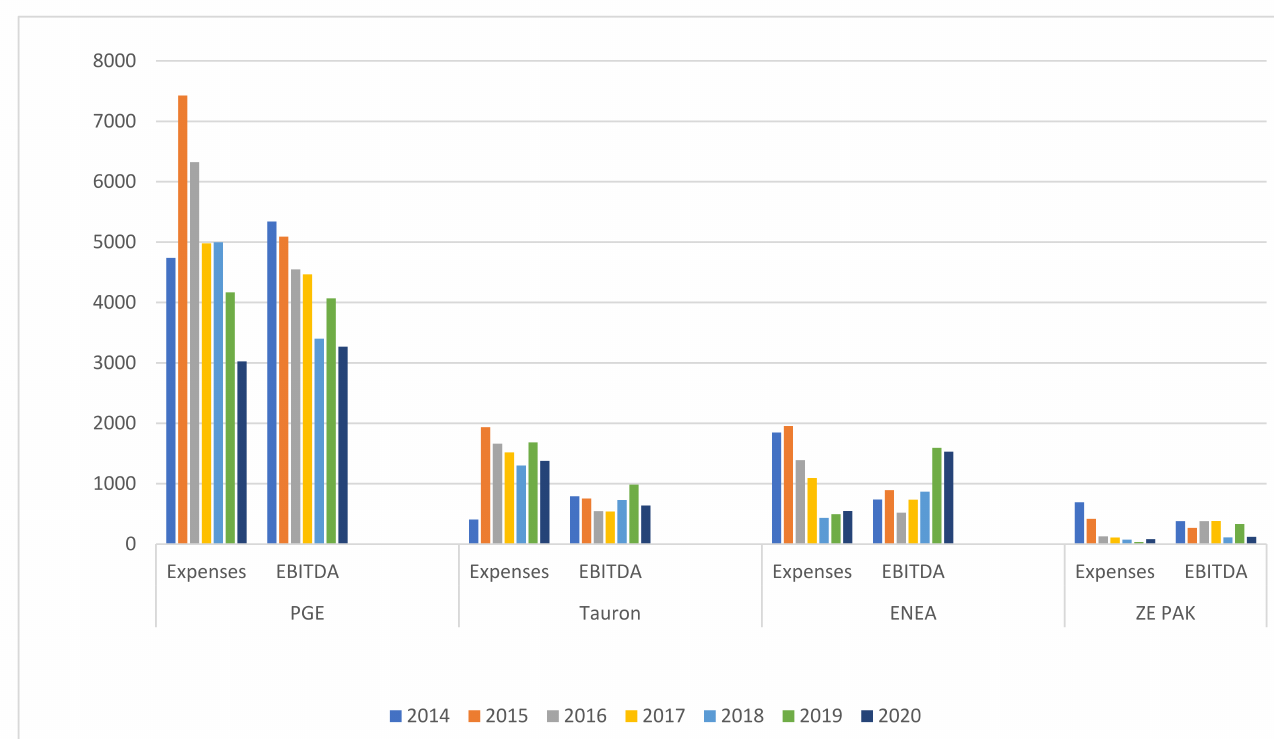
Figure 4. EBITDA ratios of the segments under review (Own